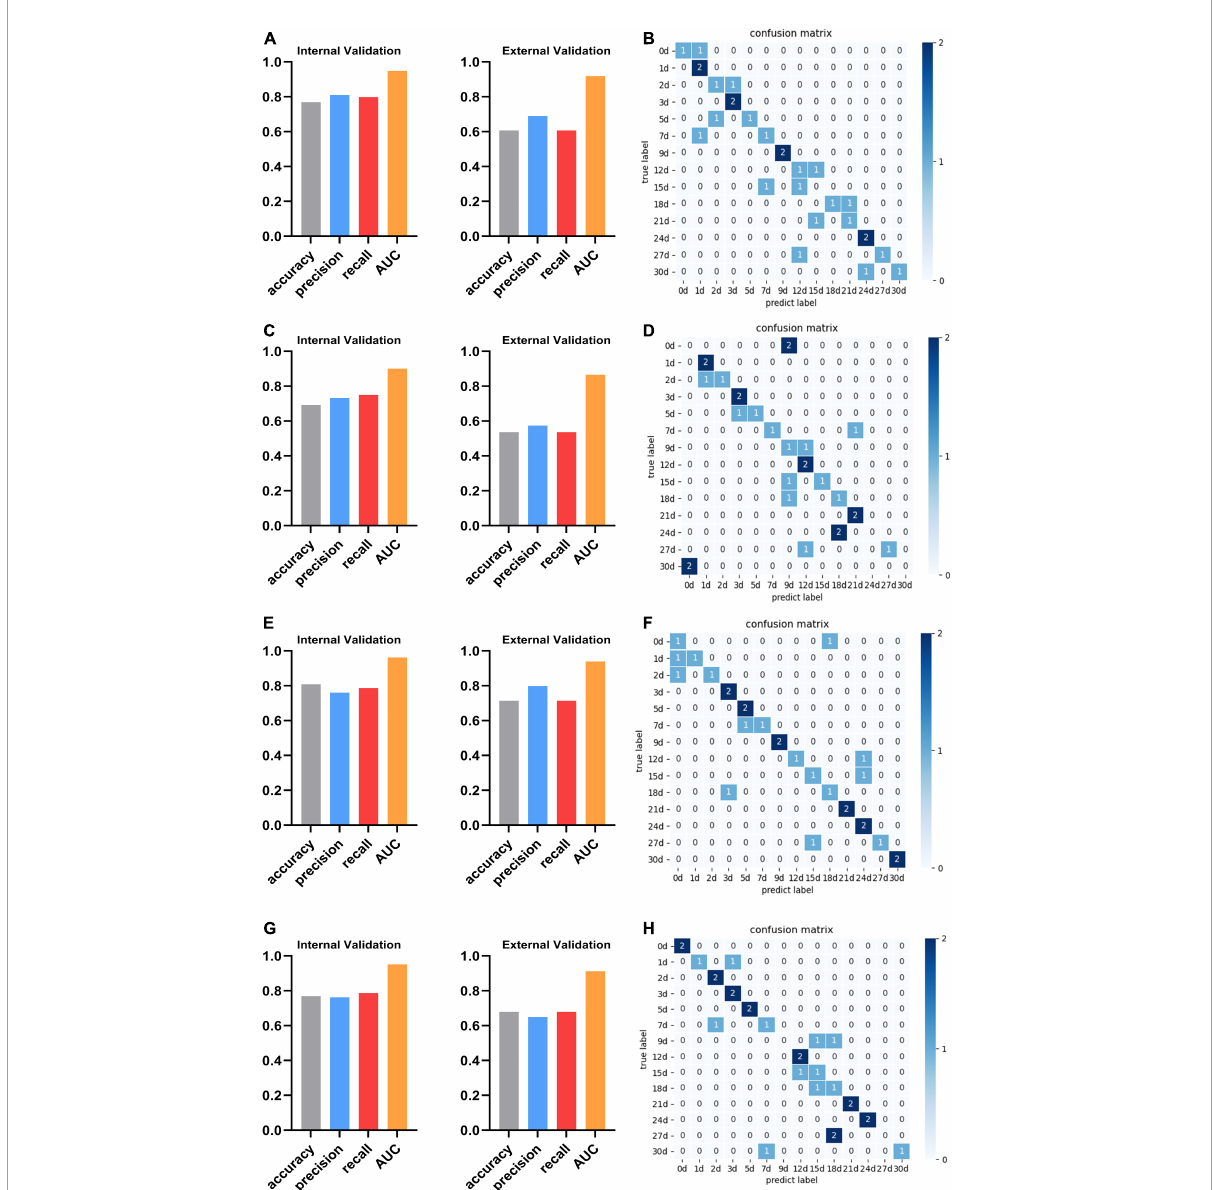
FIGURE5 The performance and confusion matrix of the optimal sub-models with the lung, liver, kidney, and skeletal muscle. (A) The optimal sub-model of the lung is SFS + RF. The accuracy, precision, recall, and AUC of internal validation are 0.769, 0.810, 0.798, and 0.948, respectively. The accuracy, precision, recall, and AUC of external verification of this model are 0.607, 0.690, 0.607, and 0.919, respectively. (B) The confusion matrix of SFS + RF for the lung shows that the external validation samples were completely predicted correctly only at 1, 3, 9, and 24 days. The external validation predictions were wrong at 15 days after death. There was a misjudgment in the samples at other PMI. (C) The optimal sub-model of the liver is SFS + RF. The accuracy, precision, recall, and AUC are 0.692, 0.732, 0.750, and 0.900, respectively. The accuracy, precision, recall, and AUC of external verification are 0.536, 0.574, 0.536, and 0.865, respectively. (D) The confusion matrix of SFS + RF for the liver shows that the external validation samples of Liver were completely predicted correctly at 1, 3, 12, and 21 days. The external validation predictions were wrong at 0, 24, and 30 days after death. There was a misjudgment in the samples at other PMI. (E) The optimal sub-model of the kidney is LASSO + RF. The accuracy, precision, recall, and AUC are 0.808, 0.760, 0.786, and 0.962, respectively. The accuracy, precision, recall, and AUC of external verification are 0.714, 0.798, 0.714, and 0.939, respectively. (F) The confusion matrix of LASSO + RF for the kidney shows that the external validation samples of Kidney were completely predicted correctly at 3, 5, 9, 21, 24, and 30 days, and there was a misjudgment in the samples at other PMI. (G) The optimal sub-model of skeletal muscle is RFE + RF. The accuracy, precision, recall, and AUC are 0.769, 0.762, 0.786, and 0.951, respectively. The accuracy, precision, recall, and AUC of external verification of this model are 0.679, 0.649, 0.679, and 0.912, respectively. (H) The confusion matrix of RFE + RF for skeletal muscle shows that the external validation samples of skeletal muscle were completely predicted correctly at 0, 2, 3, 5, 12, 21, and 24 days, The external validation predictions were wrong at 9 and 27 days after death. There was a misjudgment in the samples at other